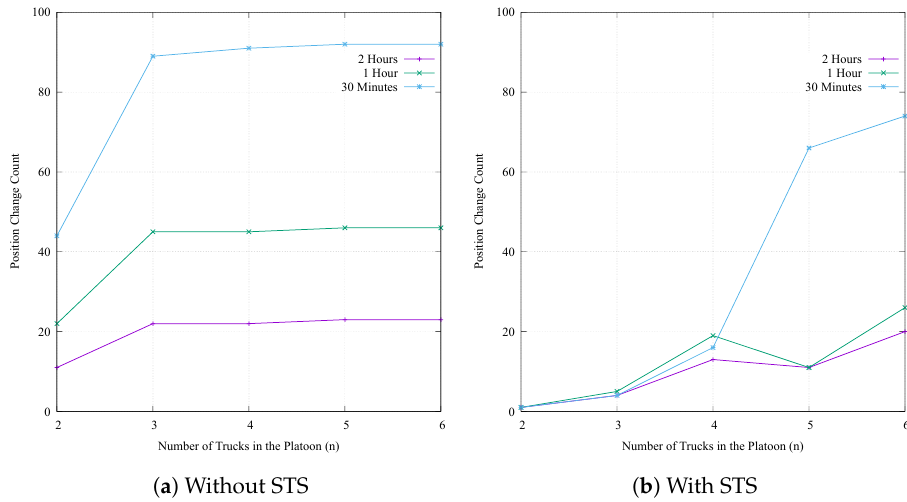
Figure 3. Performance of STS over Number of